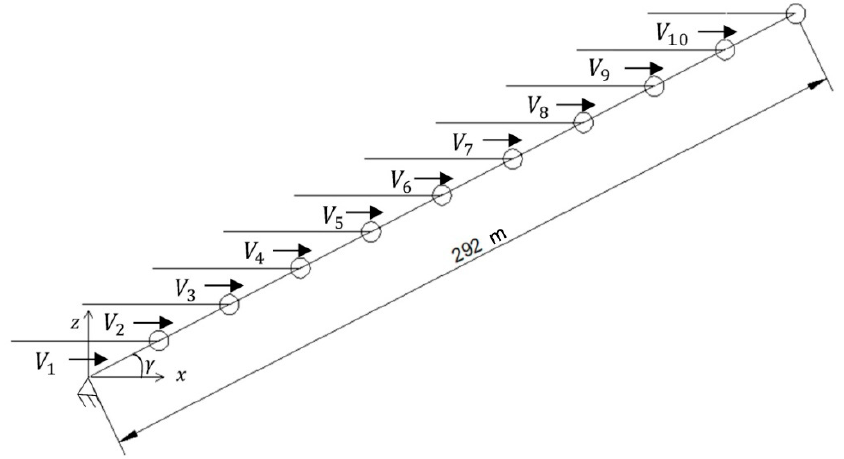
Figure 5. Representation of the ten different heights where the wind action is applied.